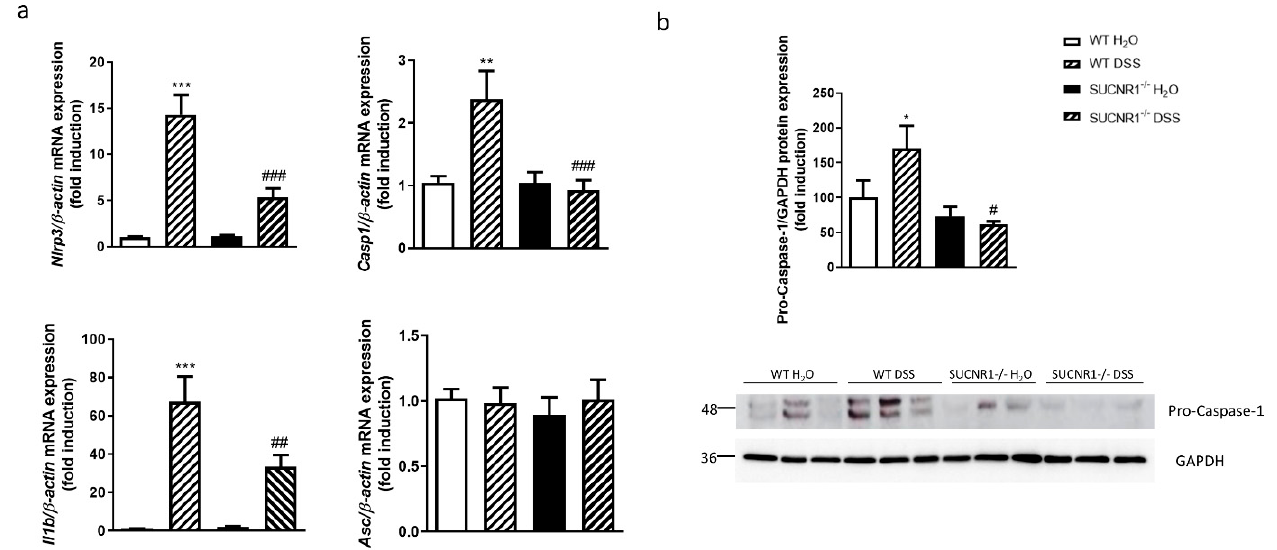
Figure 4. SUCNR1 impairs the expression of inflammasome components in DSS-chronic colitis. Chronic intestinal colitis was induced in vivo in WT and SUCNR1 − / − mice with four cycles of increasing percentage of DSS in drinking water over 7 days, intercalated with 10 days of water. At the end of the last cycle, on day 60, mice were euthanized and colon tissue samples were collected. ( a ) Graphs show mRNA expression of Nlrp3 , Casp -1, Il1b and Asc ( n = 8). ( b ) Graph shows protein expression of pro-Caspase-1 ( n = 3). Bars in graphs represent mean ± SEM. * p < 0.05, ** p < 0.01 and *** p < 0.001 vs. WT H 2 O mice. # p < 0.05, ## p < 0.01 and ### p < 0.0001 vs. WT DSS-treated mice.